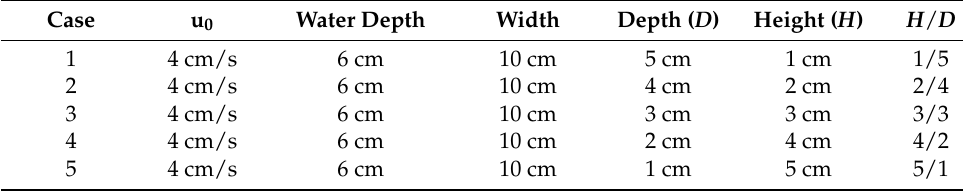
Table 3. Experimental parameter table of structural proportion